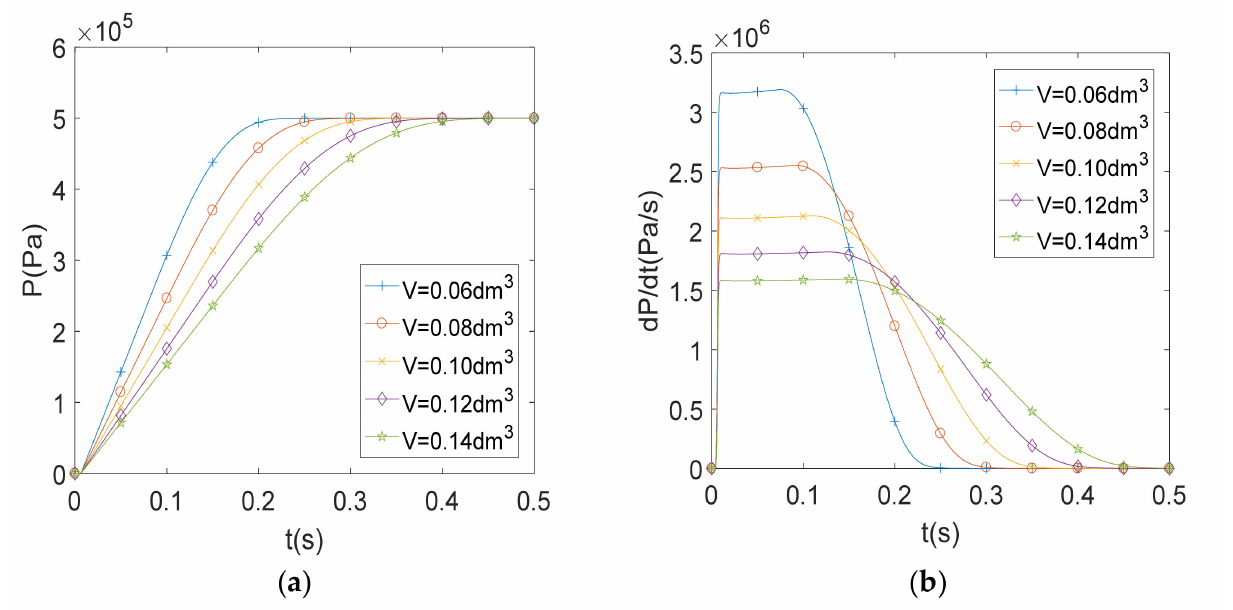
Figure 10. Influence of controlled cavity volume on pressure change rate: ( a ) pressure response; ( b ) pressure change rate